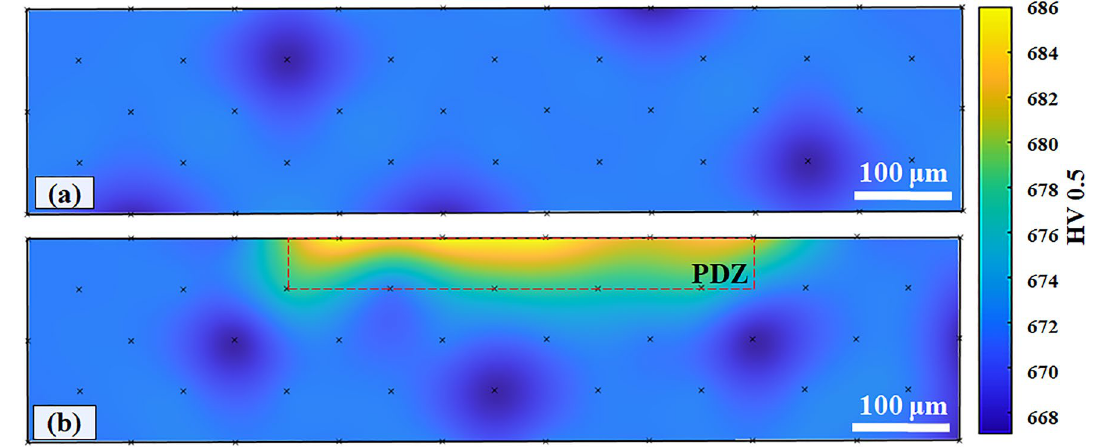
Figure 7. Cross-sectional hardness maps of the wear track of EBM-processed high carbon martensitic stainless steel at 3 N ( a ) and 10 N ( b